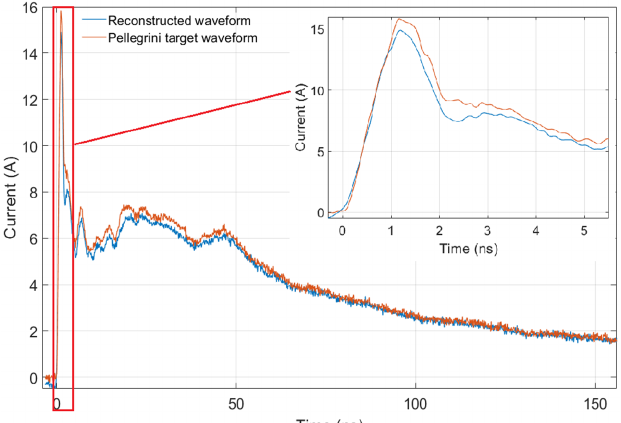
Figure 13. Comparison of the reconstructed waveform applying the proposed methodology with the Pellegrini target (reference) waveform for a +4 kV pulse of the EMC Partner Transient 3000 ESD generator including a zoomed view of the initial peak.